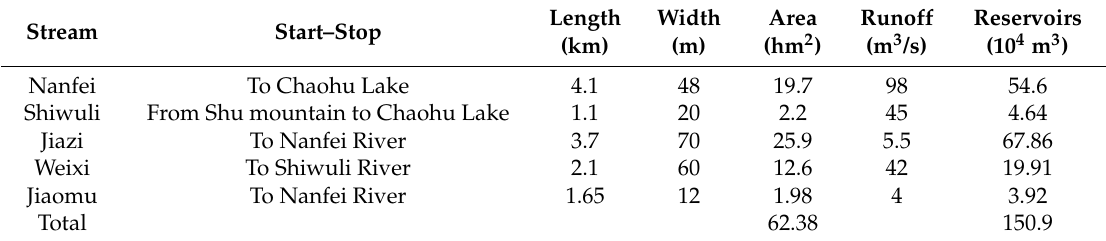
Table 1. The main rivers of Lakeside Wetland Park.